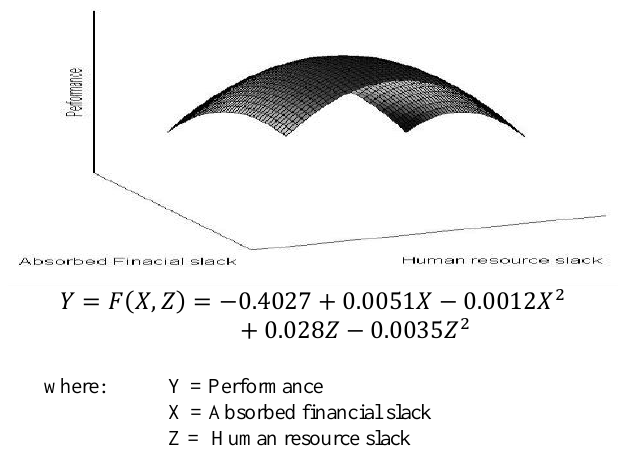
Figure 1: Curvilinear relationship between absorbed financial, human resource slacks and firm performance